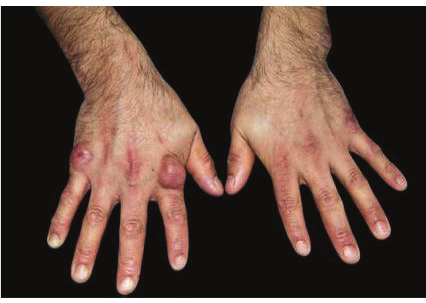
Figure 3: Bilateral hands with firm, nonmobile, nodular growths over the joints of the 2nd and 5th metacarpal phalangeal joints.